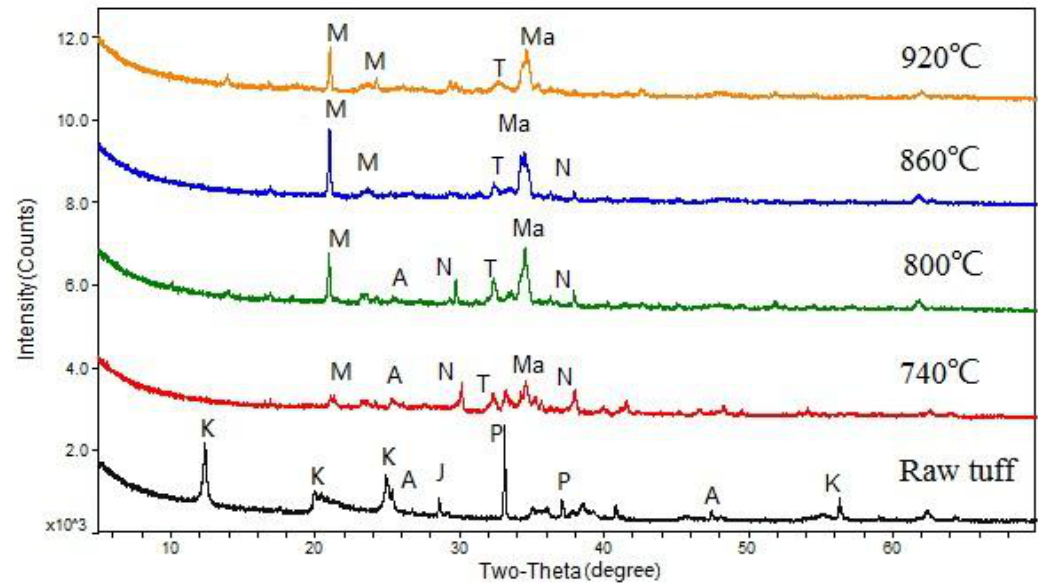
Figure 2. X-ray diffraction spectra of calcined tuff samples at different temperatures. (K: kaolinite; A: anatase; P: pyrite; J: jarosite; M: microcline; Ma: magnesiocarpholite; N: natrite; T: thermonatrite).